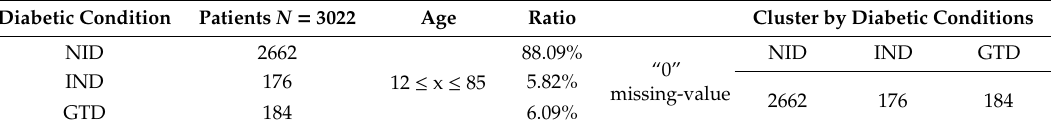
Table 1. Diabetes conditions and the number of patients classified in the assessment.